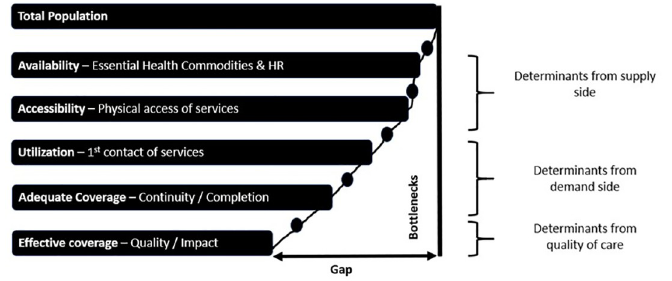
Fig 1. Tanahashi model to identify the health system